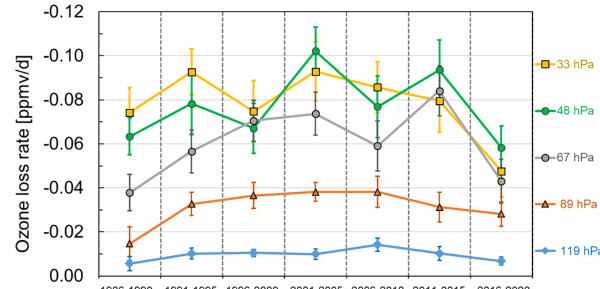
Figure 6. September loss rates (ppmvd − 1 ) calculated within 5-year blocks at five selected pressure levels within the primary depletion layer from 119hPa (13.6km) to 33hPa (20.6km) at the South Pole. The linear fit to the data includes 1 σ uncertainty bars.